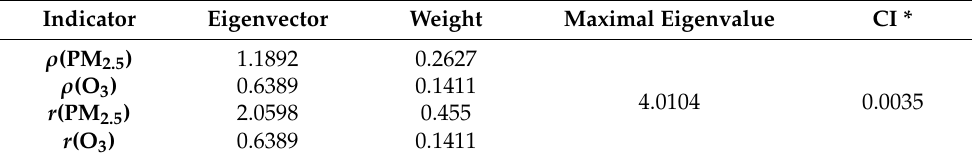
Table A2. The weights of four indicators calculated by AHP.